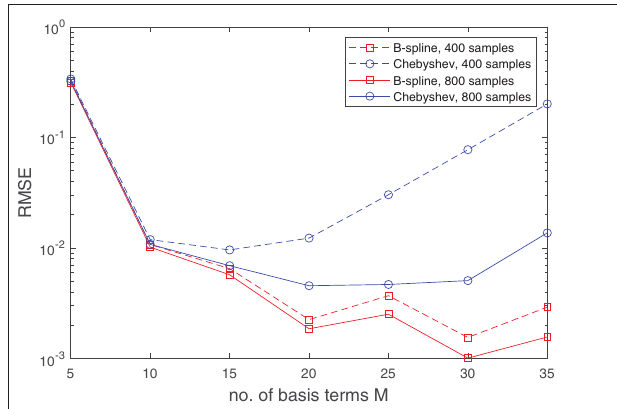
x 1 x 2 which | || | 0 and x 2 0. If a fit is = =